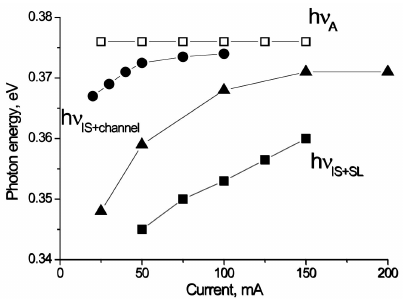
Figure 6. Dependence of the spectral position of the EL bands on the driving current at the reverse bias applied at T = 77 K (filled symbols). For comparison, the dependence of the band h ν A is shown when the forward bias has been applied (open